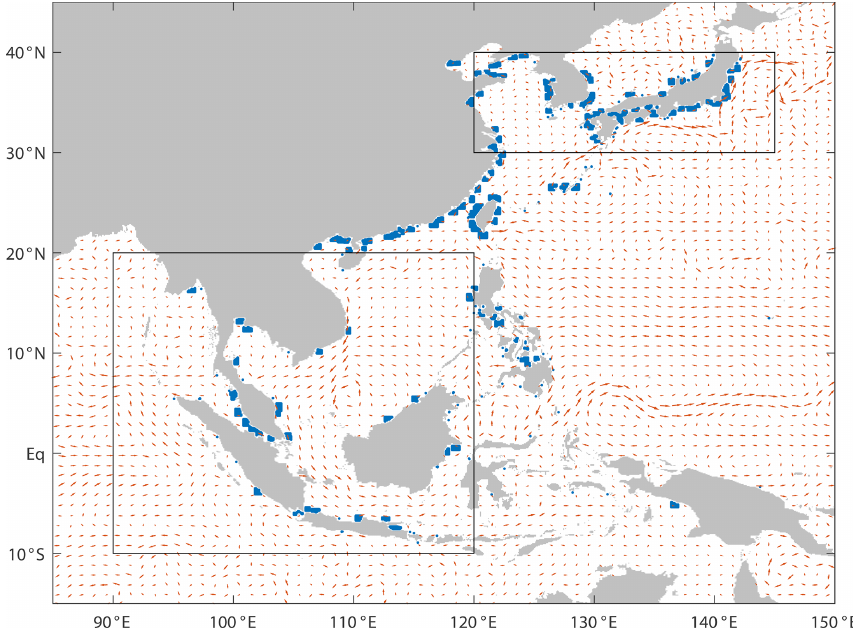
Figure 2. Initial position of particles in East and Southeast Asia (blue dots). NEMO-ORCA0083 ocean currents from the initialisation time in January 2005 (red arrows); the two boxes mark the regions referred to as tropics and subtropics as described in Sect.